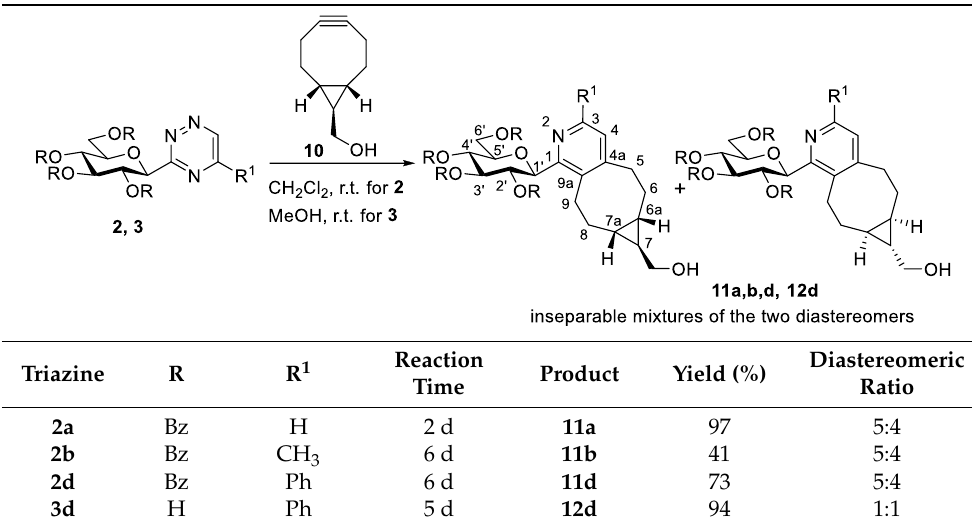
Table 4. IEDDA reactions of some 3-glucopyranosyl-1,2,4-triazines with a bicyclononyne